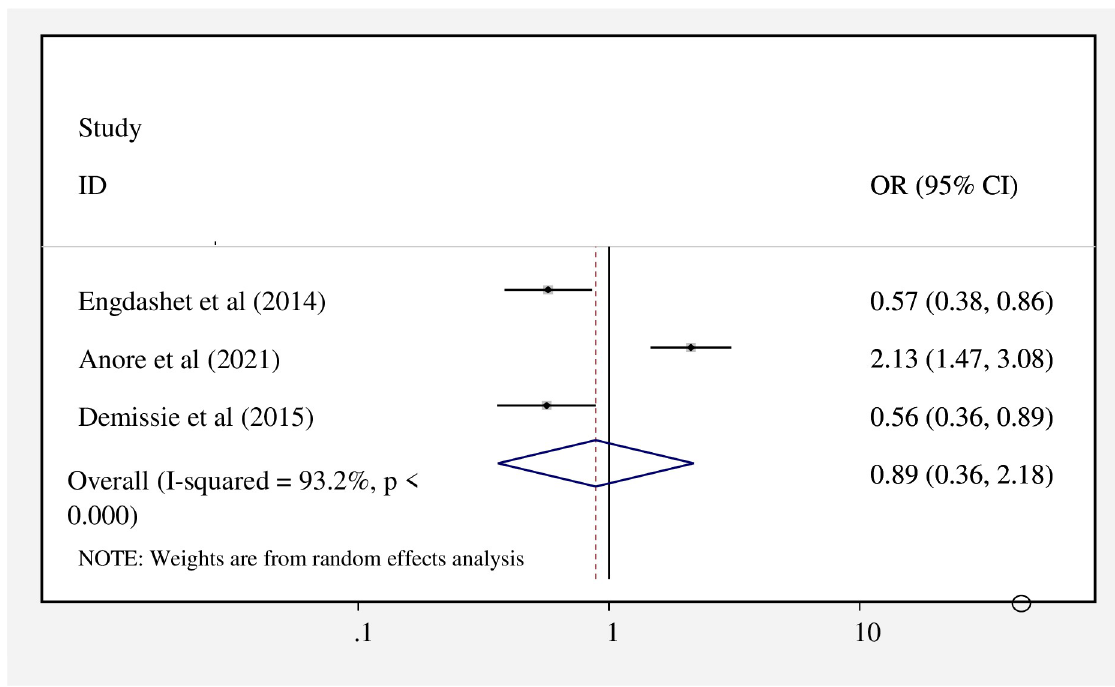
Fig 6. Forest plot showing the association between gender and risky sexual practice in